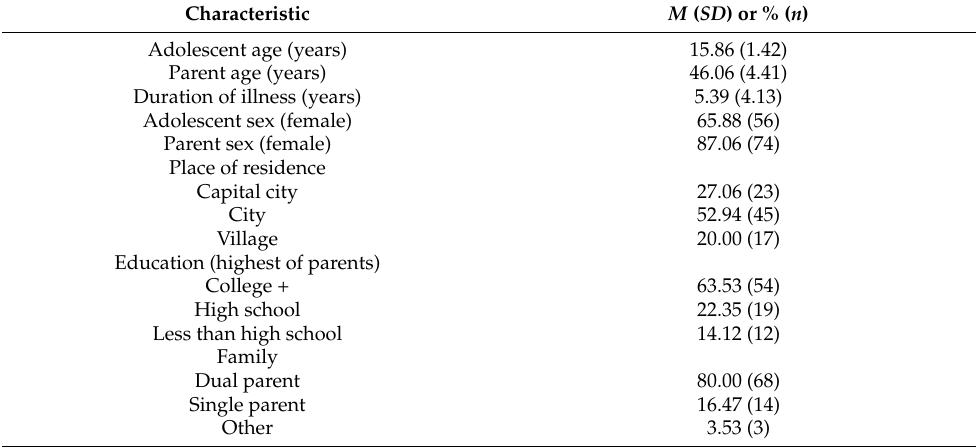
Table 1. Demographic